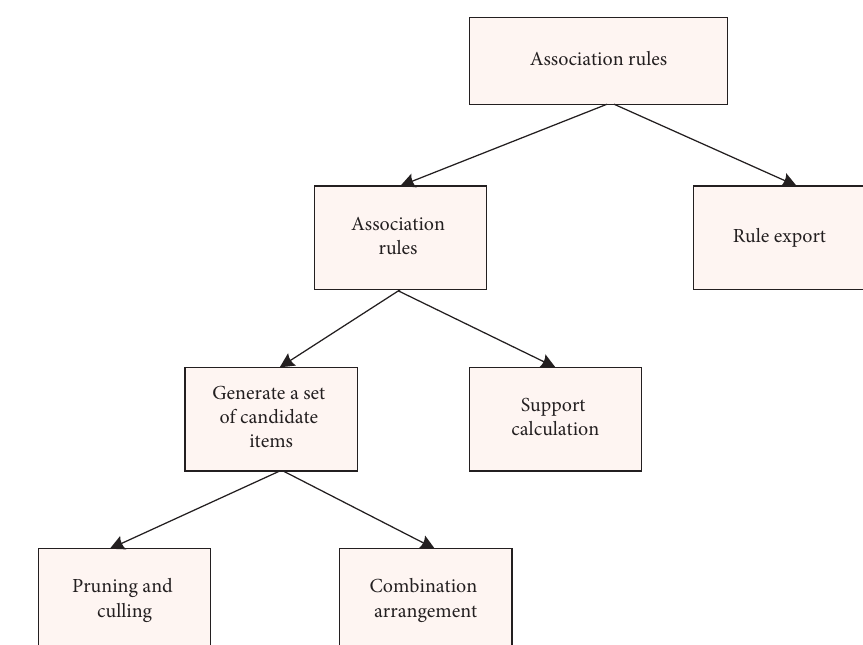
Figure 2: The structural framework of the Apriori